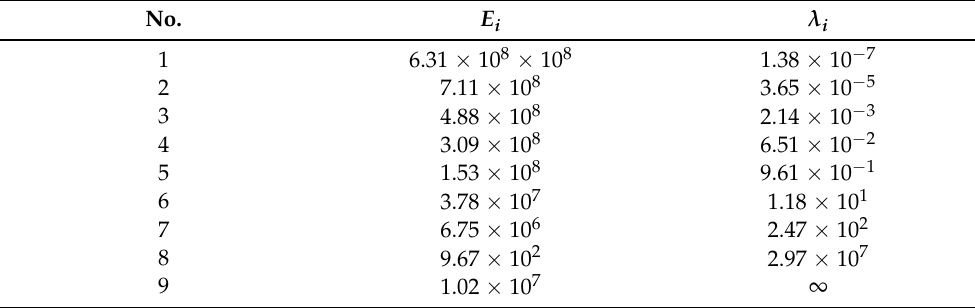
Table 5. E i and λ i for Polymer